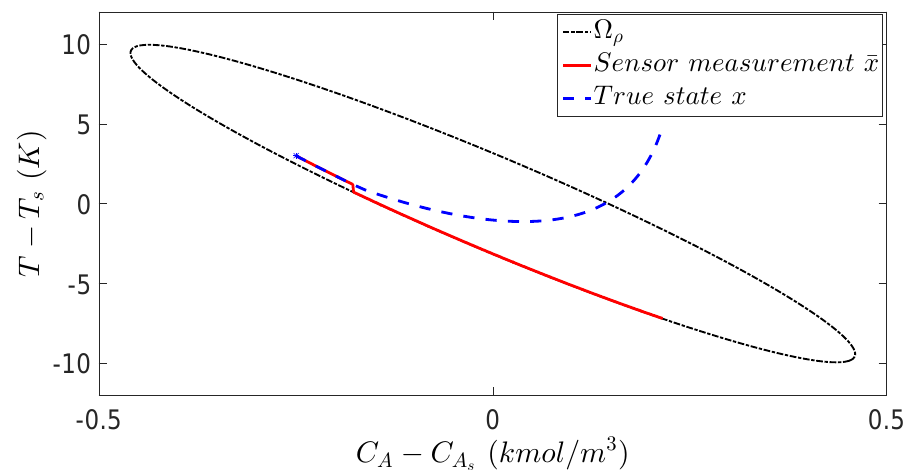
Figure 5. The state-space profile for the CSTR of Equation (15) under the LMPC of Equation (14) and under a min-max cyber-attack for the initial condition ( − 0.25, 3).